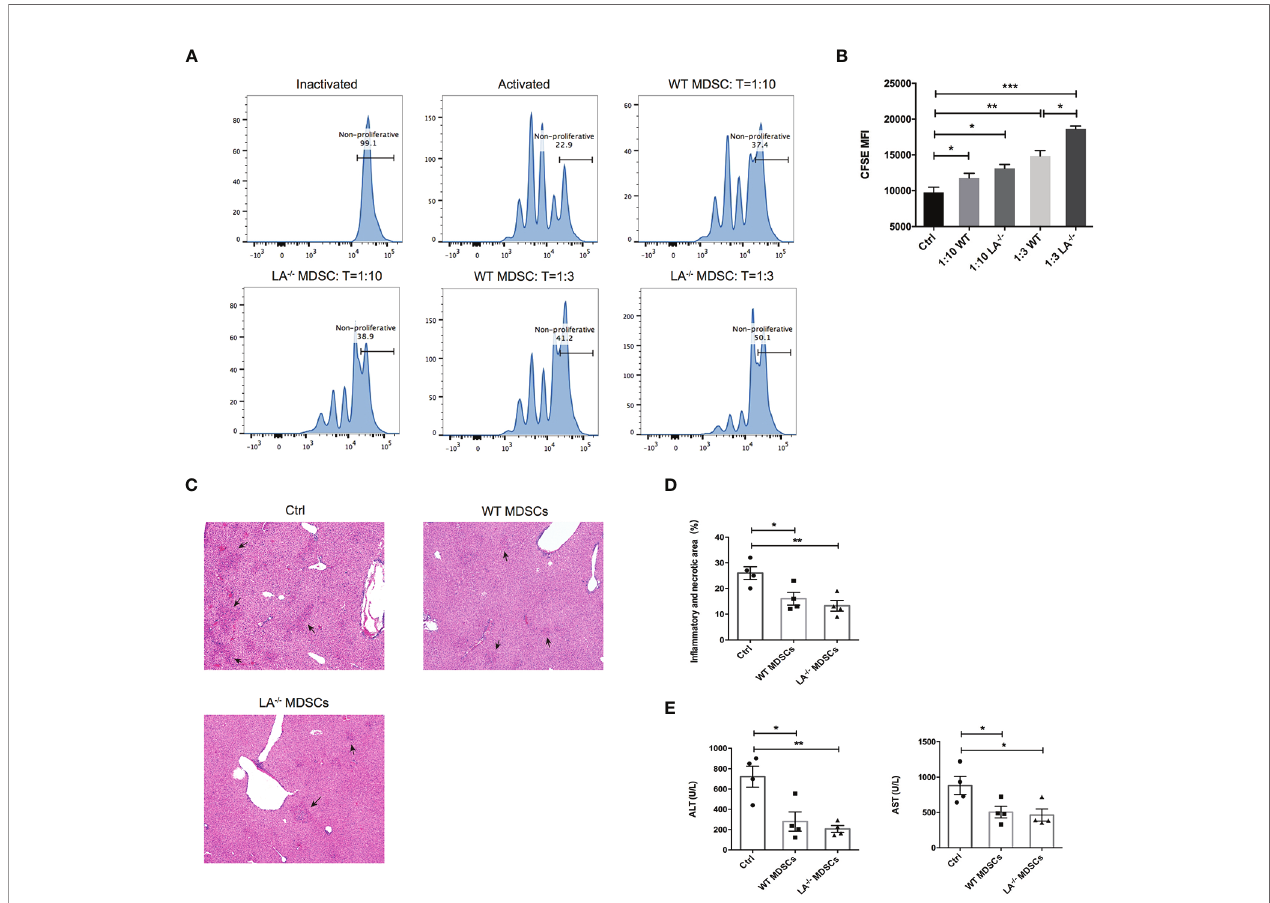
FIGURE 4 | MDSCs expanded in murine model of ConA possess immunosuppressive function and prevented T-cell-mediated liver injury. (A, B) CFSE of proliferating T cells cocultured with MDSCs at different ratios (10:1 and 3:1). MDSCs were puri fi ed and bulked from liver of WT and LXR a − / − mice after 16-h treatment of ConA. To satisfy the cellular amount for adoptive transfer experiment, MDSCs were magnetic sorted from the bone marrow of WT and LXR a − / − mice challenged with ConA for 3 (h) Each recipient WT mice was injected 5 × 10 6 MDSCs and 1 h later treated with ConA. Mice that received PBS were used as positive control. (C, D) Liver histology and the quanti fi cation of in fl ammatory and necrotic area. (E) Serum levels of ALT and AST. Data are presented as mean ± SEM. * p > 0.05, ** p < 0.01 and *** p <